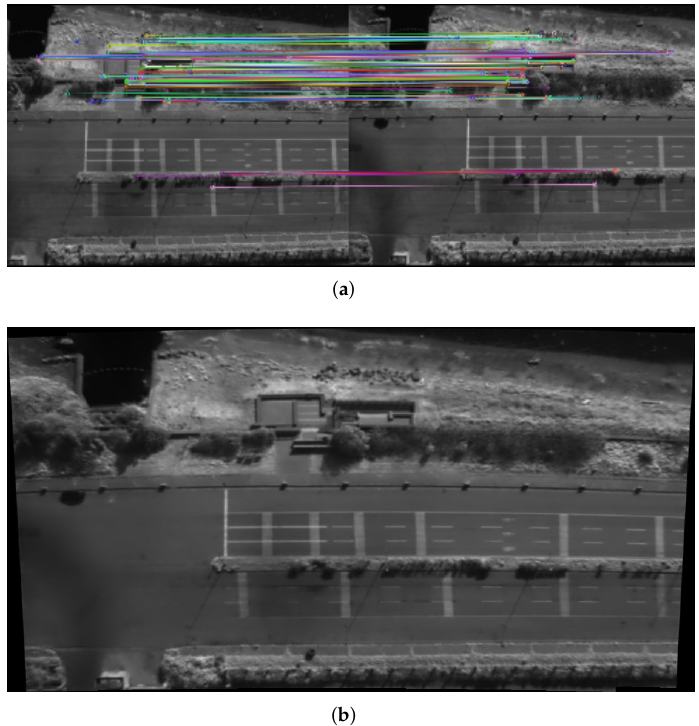
Figure 5. Aerial SWIR remote-sensing map construction using two SWIR images. ( a ) The key feature selection process. ( b ) The result of aerial SWIR image map construction.